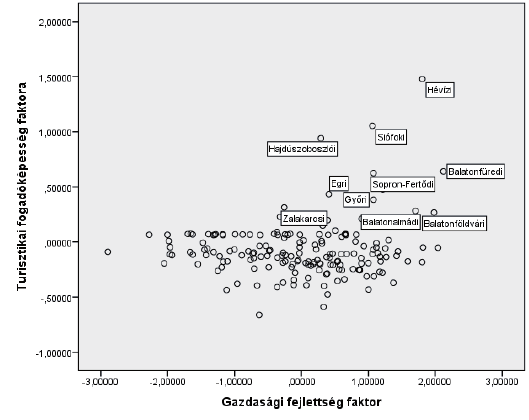
Fig. 4 – Scatter graph. Tourism Capacitability and the Economic Development (Vertical: Tourism C. / Horizon- tal: Economic D.) Source: own